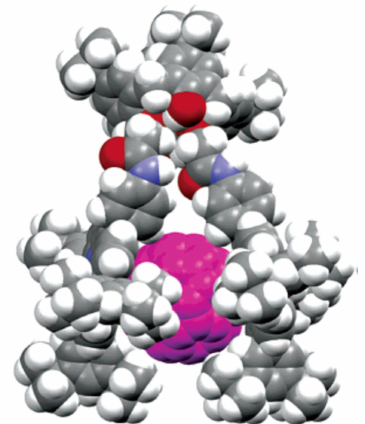
Figure 5. Molecular modeling structure of 26-C60 showing the close approach of the 10,20- tert - butylphenyl substituents to C60 and the more distant approach of the 15- tert -butylphenyl sub- stituent